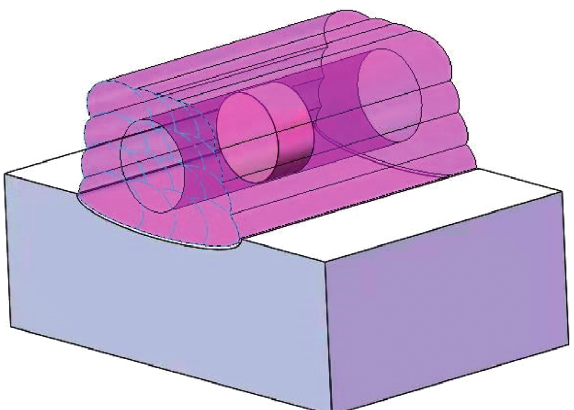
Figure 1: Sampling location.